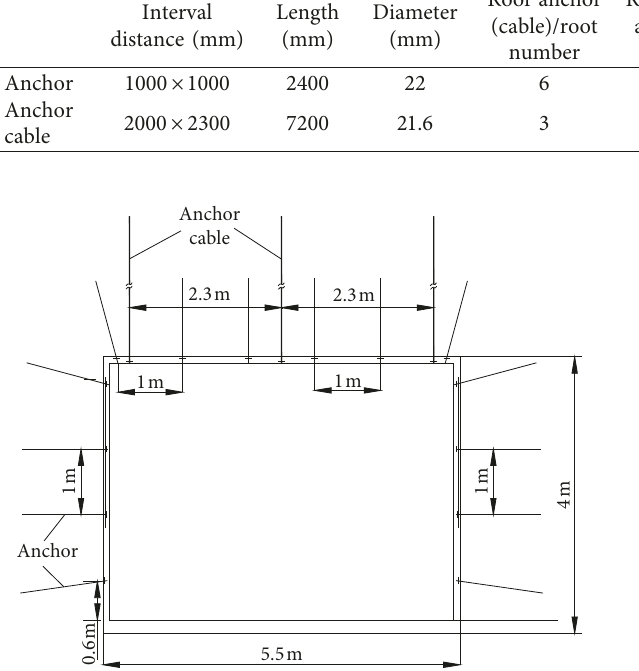
Figure 4: Layout of roadway support section.